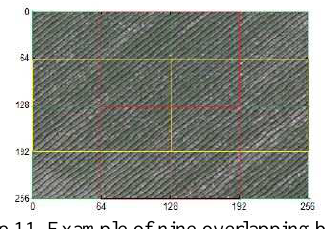
Figure 11. Example of nine overlapping blocks.